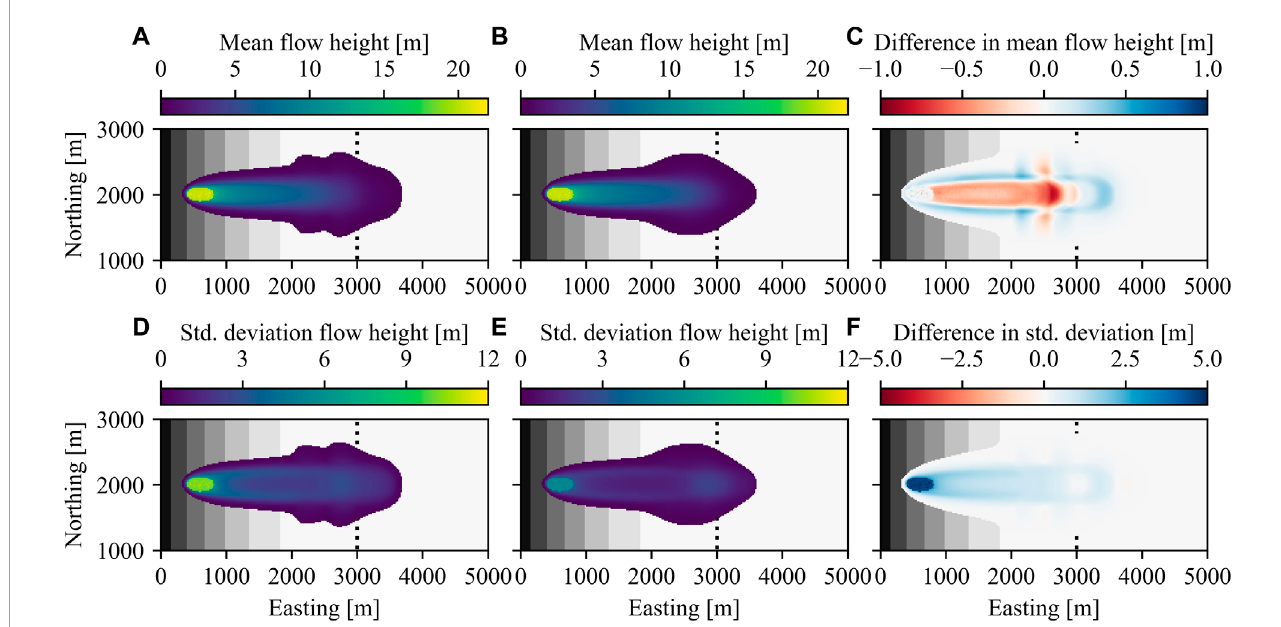
FIGURE 7 Spatial distribution of mean and standard deviations of maximum flow height ( h max ) from synthetic case obtained with (A, D) Point Estimate Method (PEM) and (B, E) Monte Carlo Simulations (MCS) at 50% coefficient of variation. Differences of (C) mean value and (F) standard deviation are plotted by subtracting MCS results from PEM results.